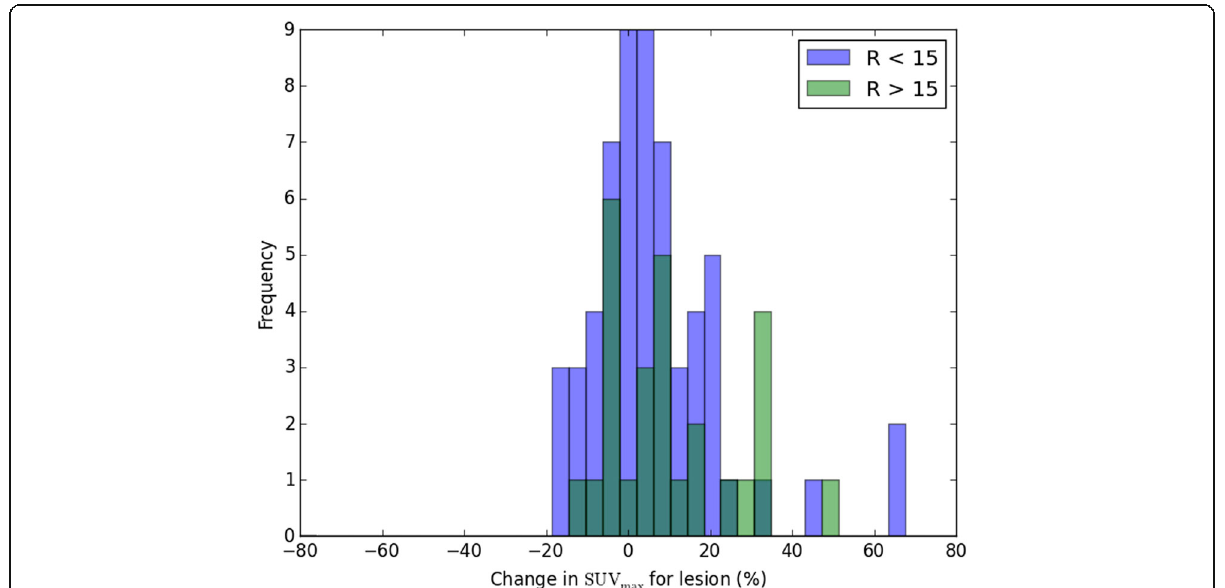
Fig. 7 Histogram of change in SUV max . The data are split into two groups based on the corresponding R values, below and above an R value threshold of 15. Where data are overlaid, a darker colour bar is